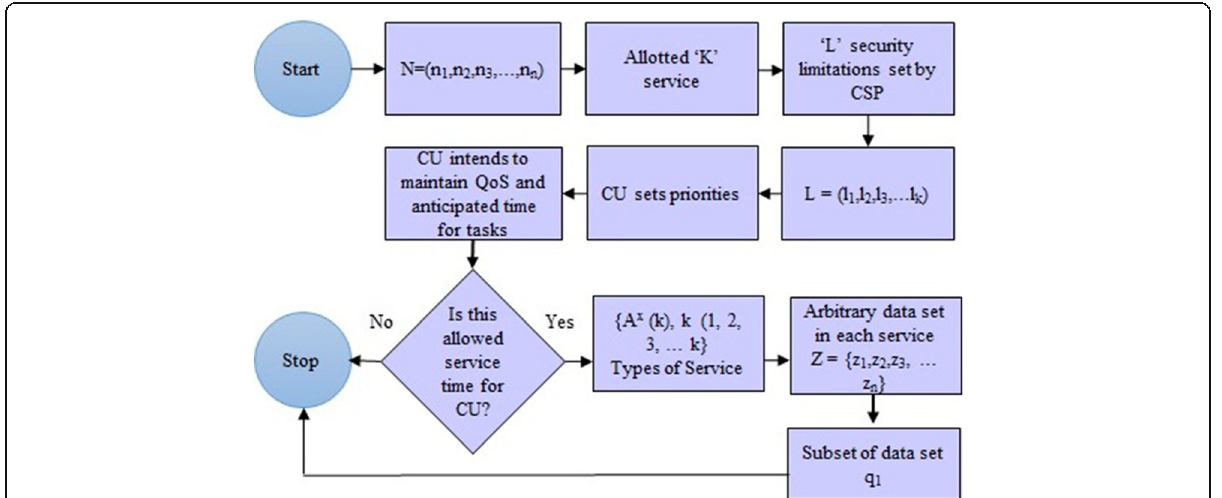
Fig. 3 Functional behavior of service-type to ensure the privacy-preserving authentication